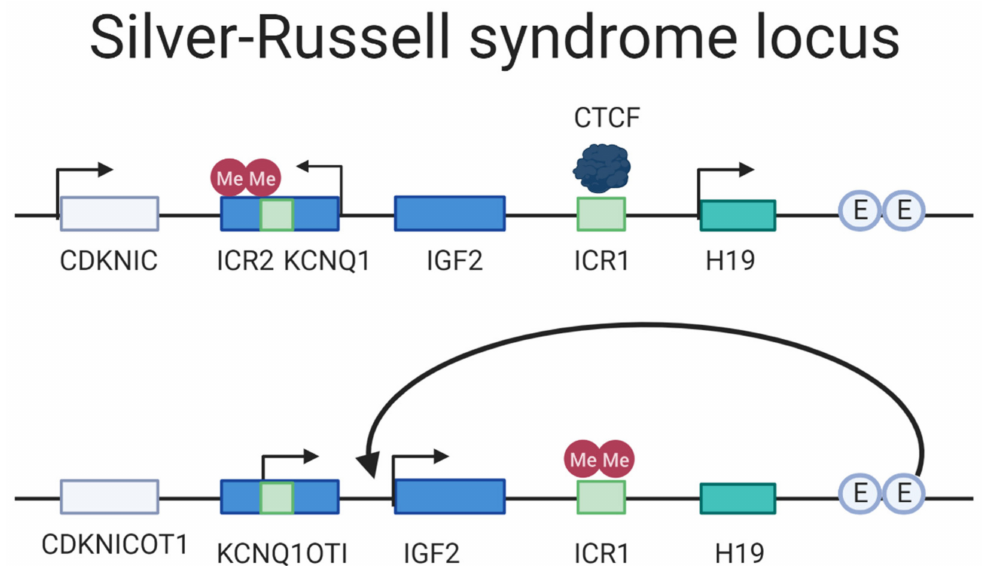
Figure 6. Locus overview of the SRS region. The upper drawing depicts the maternal regulation of the locus. The ICR2 is hypermethylated where the maternally expressed genes KCNQ1 and CDKNIC are expressed. The ICR1 is not methylated, allowing the CTCF motif to bind it and hindering the enhancers (E) to activate IGF2 expression. The lower drawing paternally inherited ICR1 is methylated, thus inhibiting CTCF binding and allowing the enhancers to regulate IGF2 transcription. The ICR2 is not methylated paternally and the non-coding transcript KCNQ1OTI is expressed. Adapted from: Azzi et al. (2009)